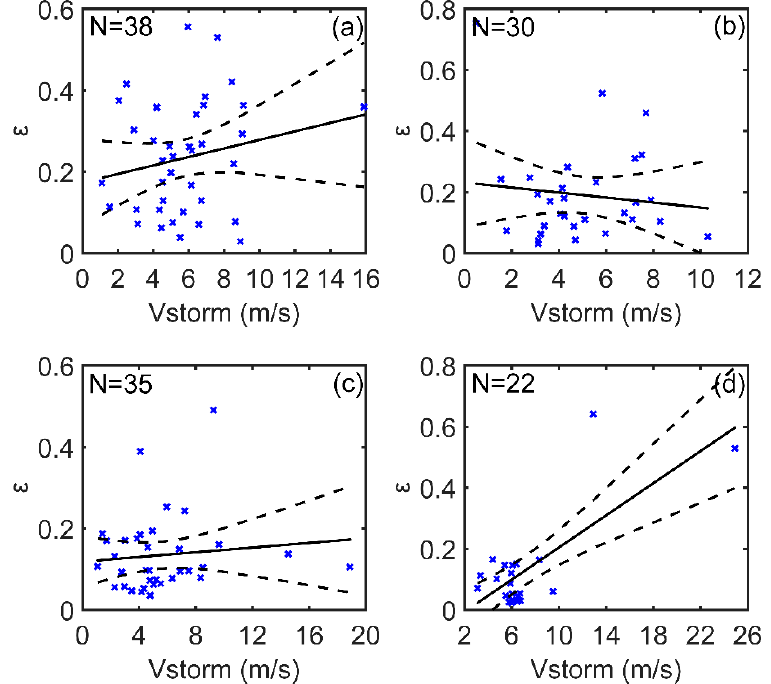
Figure 7. Asymmetry parameter ( ε ) versus typhoon translation speed ( V storm ) for ( a ) a tropical storm, ( b ) typhoon, ( c ) severe typhoon, and ( d ) super typhoon, as shown in Figure 3. The number of storms for each group is marked. The black solid and dashed lines represent linear regressions and 95% confidence intervals for the fits, respectively.